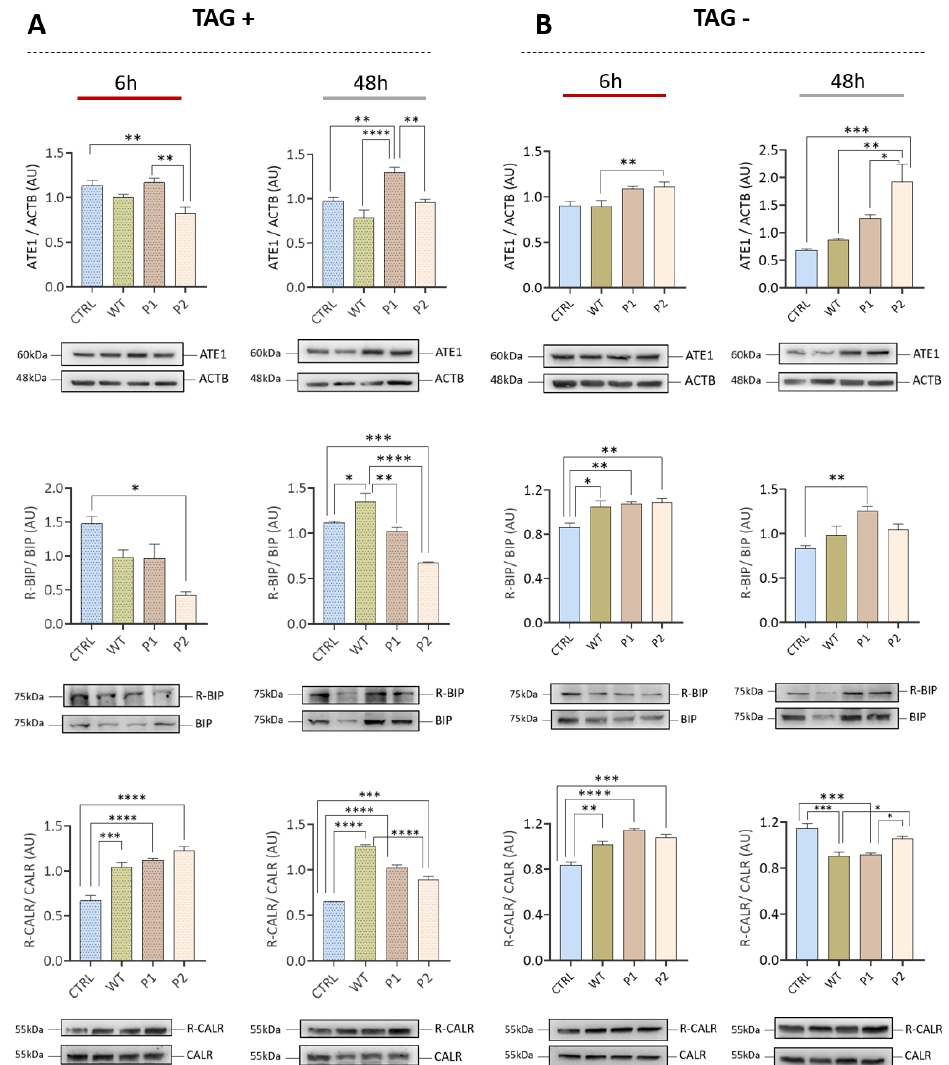
Figure 5. Modulation of arginylation after infection with WT (Wuhan), P1, and P2 (Brazil) variants. Calu-3 cells infected with WT, P1, and P2 variants were evaluated at 6 hpi and 48 hpi when exposed to the stress inducer thapsigargin ( A ) or not exposed ( B ). Each point represents an independent experiment ( n = 3). The significance level indicates: **** p < 0.0001; *** p < 0.001; ** p < 0.005; * p < 0.05.